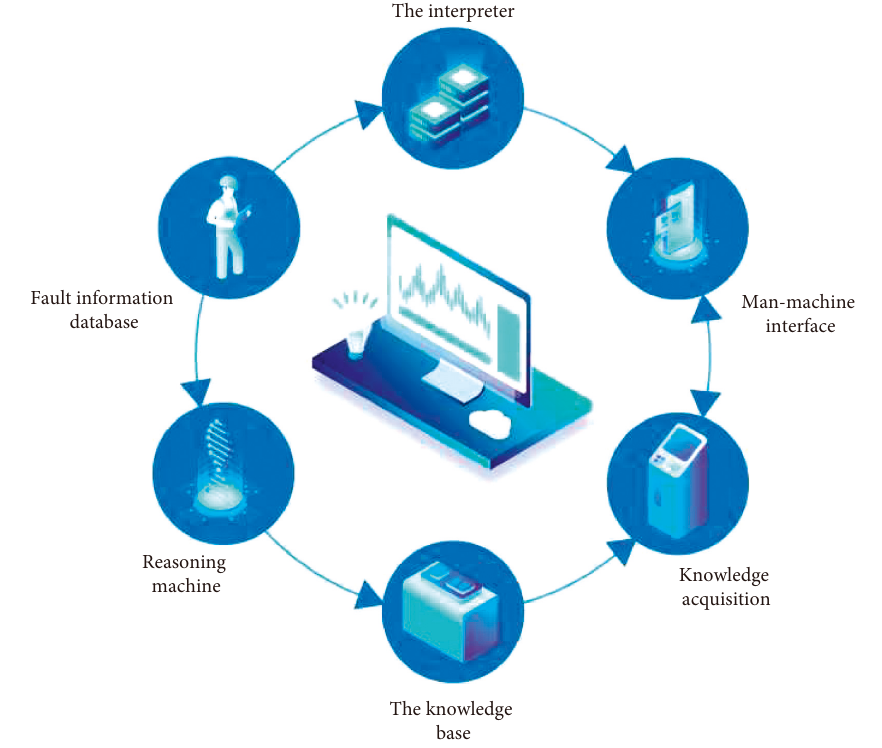
Figure 1: Fault diagnosis of the wind turbine